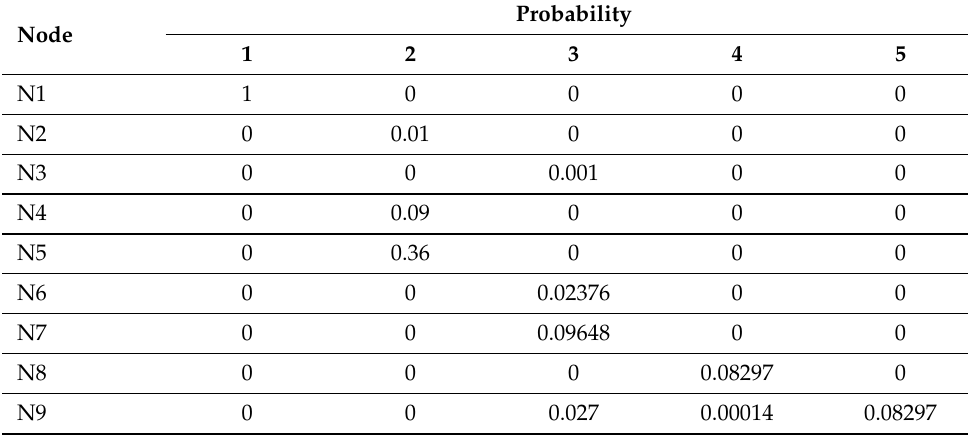
Table 5. Accumulated probability matrix